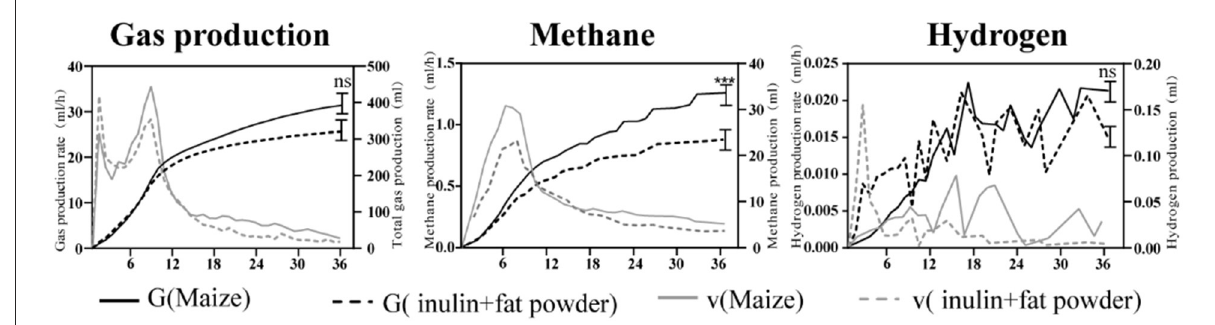
FIGURE1 Gas production and gas generation rate of in vitro rumen fermentation. G(Maize), gas production by 0.5g maize-grain based substrate; v(Maize), generation rate of gas production of 0.5g maize-grain based substrate; G(inulin + fat powder), gas production of 0.5g inulin-fat mixture (0.2838g inulin, 0.2162g fat powder) based substrate; v(inulin + fat powder), gas generation rate of 0.5g inulin-fat mixture (0.2838g inulin, 0.2162g fat powder) based substrate. ***Indicates that p -value is < 0.001.